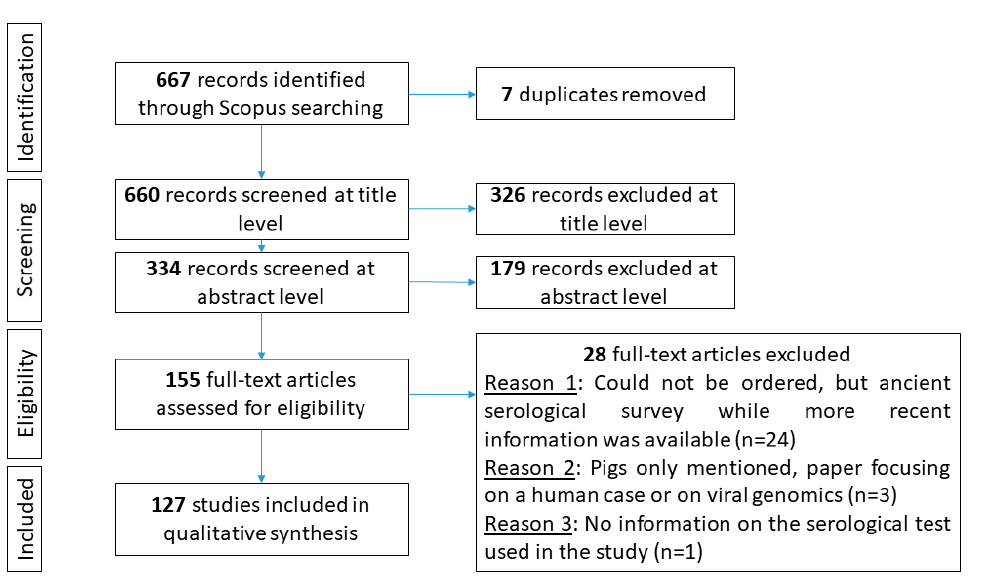
Figure 1. Preferred Reporting Items for Systematic Reviews and Meta-Analyses (PRISMA) flow diagram representing the selection process .